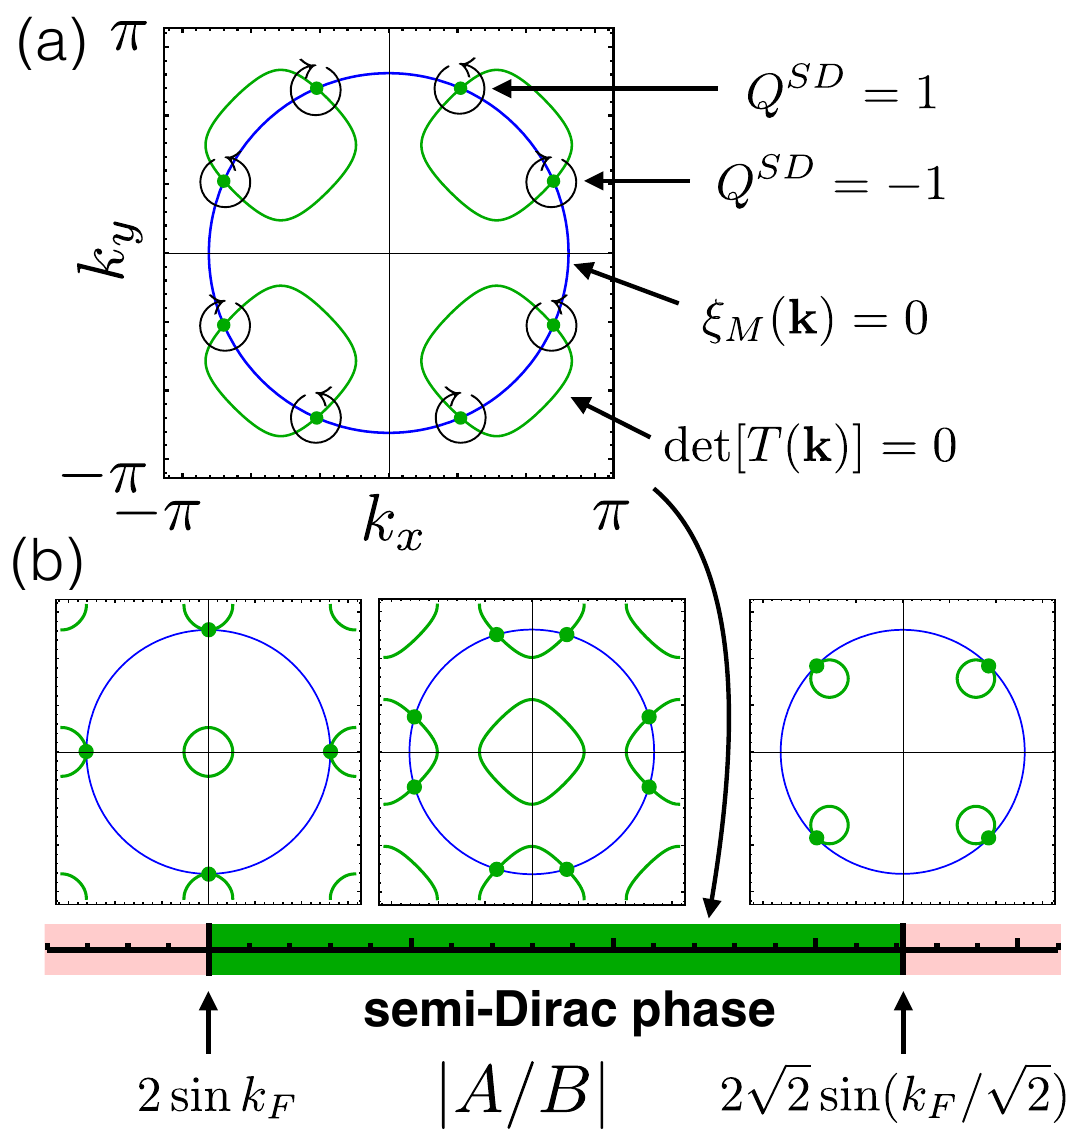
Figure 4: Illustration of the apperance of robust semi-Dirac points. (a) In the semi-Dirac phase ( k ) < 0 and det [ T ( k )] < 0 partially overlap, so that there exists robust nodal the regions of ξ M ( k ) = 0 and det [ T ( k )] = 0. These nodal points points at the intersection points of the lines ξ M are therefore stable against small perturbations of the parameters of the model and they carry topological charges Q SD = ± 1 [ Eq. (22) ] . The low-energy theory in the vicinity of these nodal points is described by the semi-Dirac Hamiltonian [ Eq. (2) ] i.e. the dispersion is linear in the direction perpendicular to the Fermi line, and quadratic in the direction along the Fermi line. (b) Phase diagram for the model described by the Hamiltonian (10) with tunneling matrix (cid:112) (cid:112) (cid:0) (cid:1) / < (cid:12) (cid:12) A / B (cid:12) (cid:12) < 2 k 2sin 2 . Outside this (13). The semi-Dirac phase appears for 2sin k F F region of parameters the system is in a trivial fully gapped phase. The semi-Dirac points with opposite topological charges are nucleated / annihilated in a pairwise manner, so that in the vicinity of the transition points between the semi-Dirac phase and the trivial phase the system (cid:12) (cid:12) is described by the Hamiltonian (6). At (cid:12) A / B (cid:12) = 2sin k F the merging of the semi-Dirac points (cid:112) (cid:112) (cid:0) (cid:1) ) = : ( ± k ) . At (cid:12) (cid:12) A / B (cid:12) (cid:12) = 2 / k occurs at ( k , k ,0 ) , ( 0, ± k 2sin 2 the merging occurs at (cid:112) x y F F F ( k ) = : ( ± k ) / = 5 π/ 6. , k , ± k 2. In the figures we have chosen k x y F F F